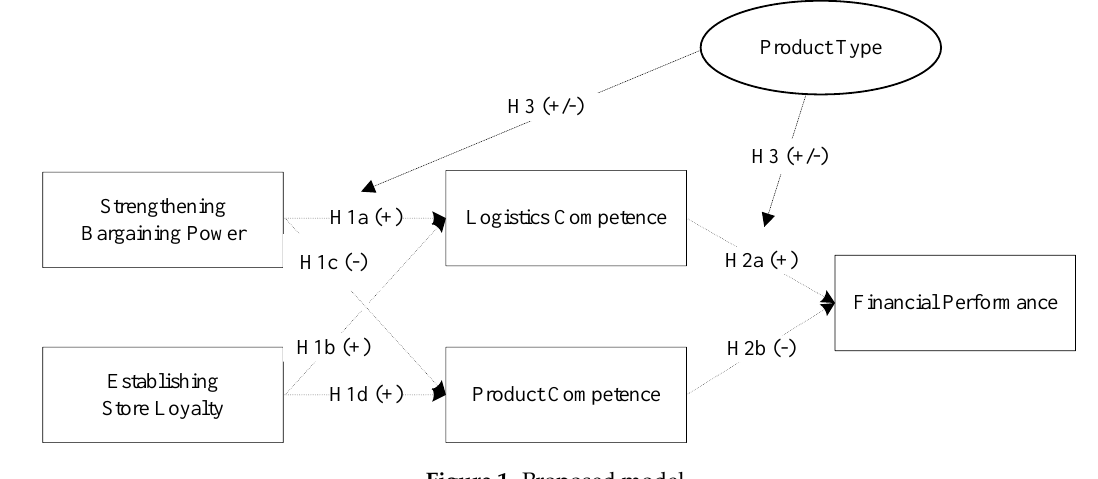
Figure 1. Proposed model.